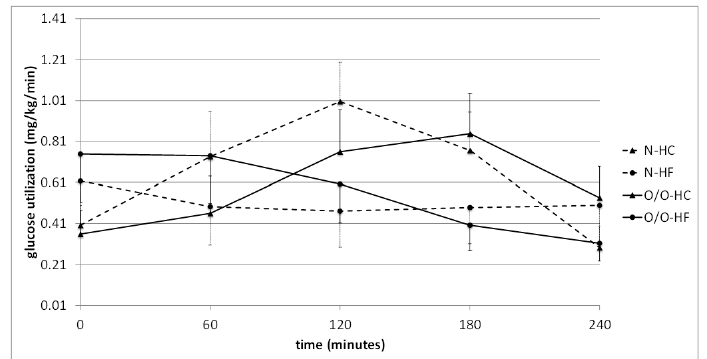
Figure 5. Glucose utilization (mg/kg/min) in people with normal body weight (N, the broken line) and overweight/obese people (O/O, the solid line) in fasting state (time 0 min) and after consumption (time 60–240 min) of a high-carbohydrate meal (HC) and a high-fat meal (HF). The results are presented as mean values ± SE. The comparison between study groups N and O/O; the comparison between meals HC and HF.